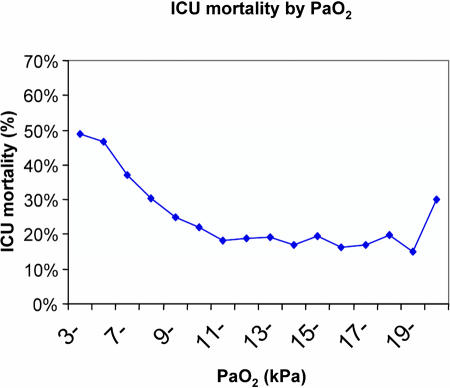
Mortality Rises Steadily as PaO2 Falls